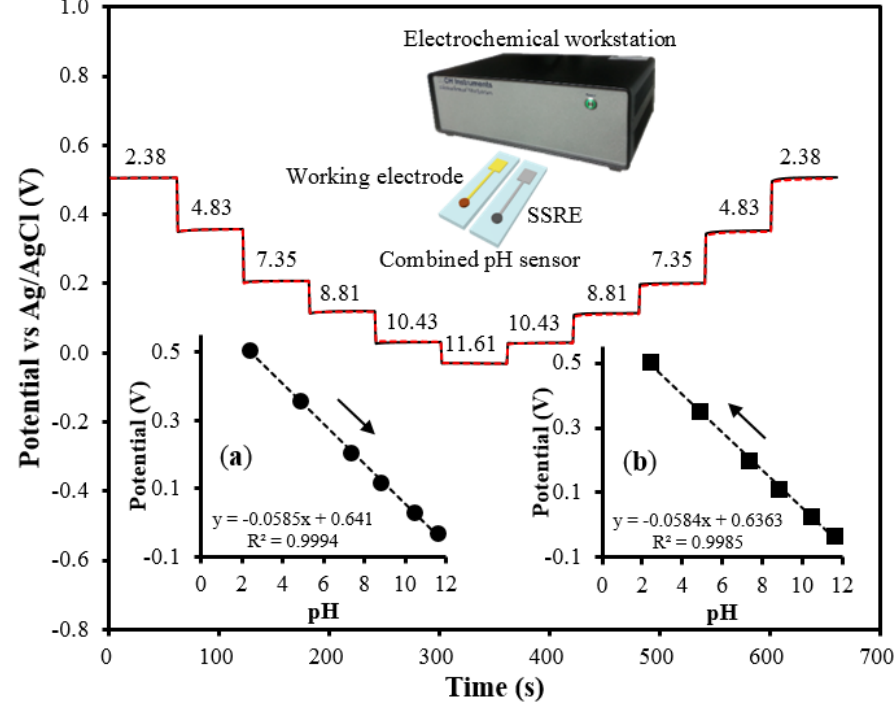
Figure 8. The combined pH sensor and the electrochemical workstation were used for measuring the potentials. The potentials measured with the pH sensor are represented by the straight (―) and dotted (---) lines. The numbers in the graph indicate the pH. ( a ) and ( b ) show the proportional relation between the pH and the potentials in the acid-to-base direction and vice versa , respectively (the measurements were made three times, and the arrows indicate the direction for pH